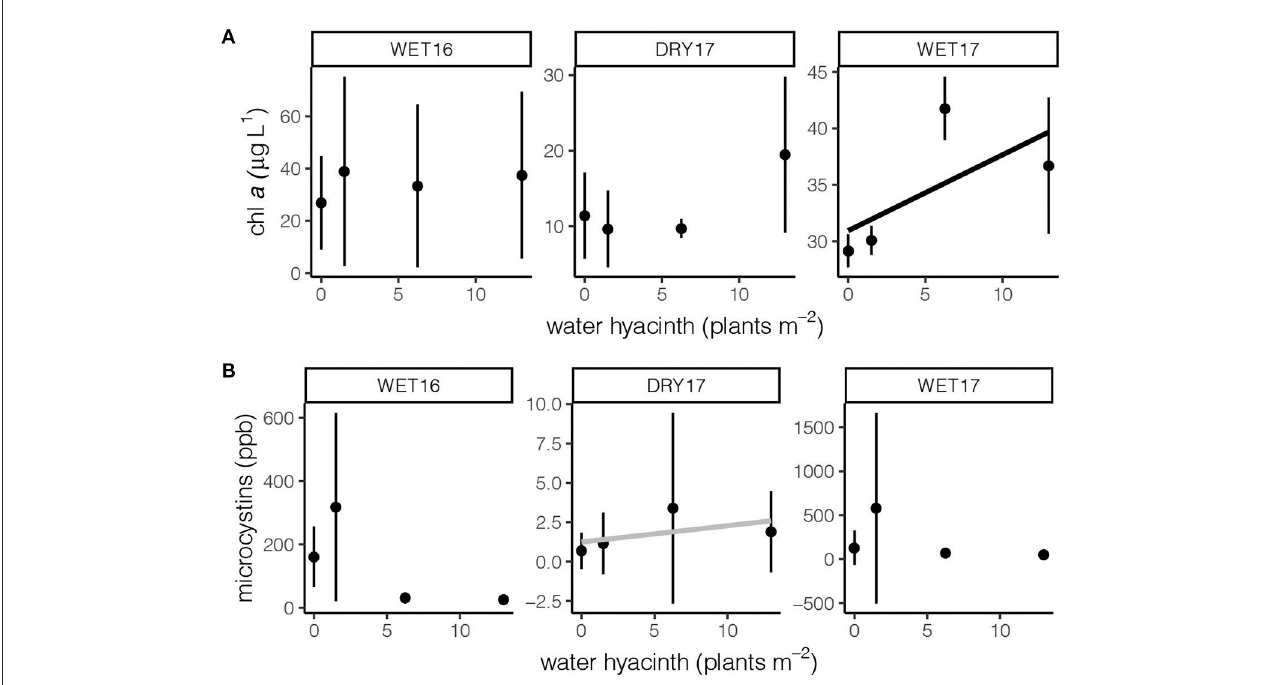
FIGURE6 The impact of water hyacinth density on (A) chlorophyll a and (B) total microcystin concentration. The black line indicates a significant response ( p < 0.05), the gray line indicates a nearly significant response ( p < 0.10). Note differences in scale among